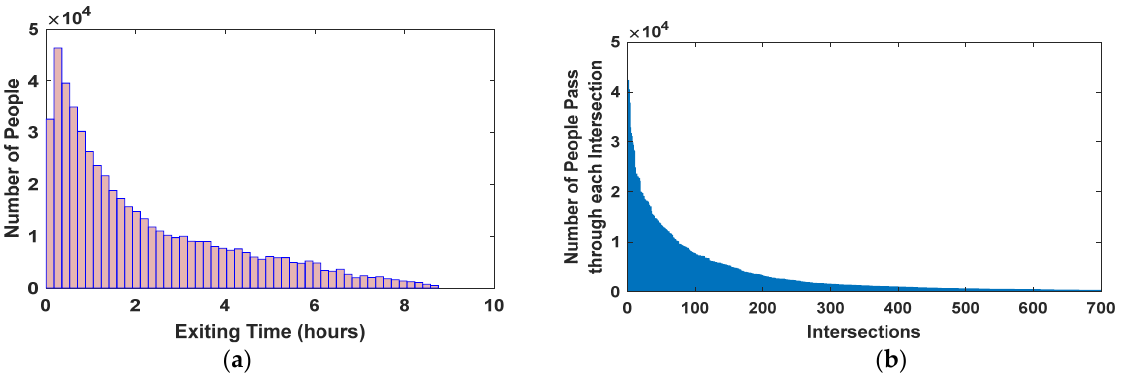
Figure 10. ( a ) Number of people exiting the system vs. time (hours) ( b ) Number of people passing through intersections in GC (sorted).